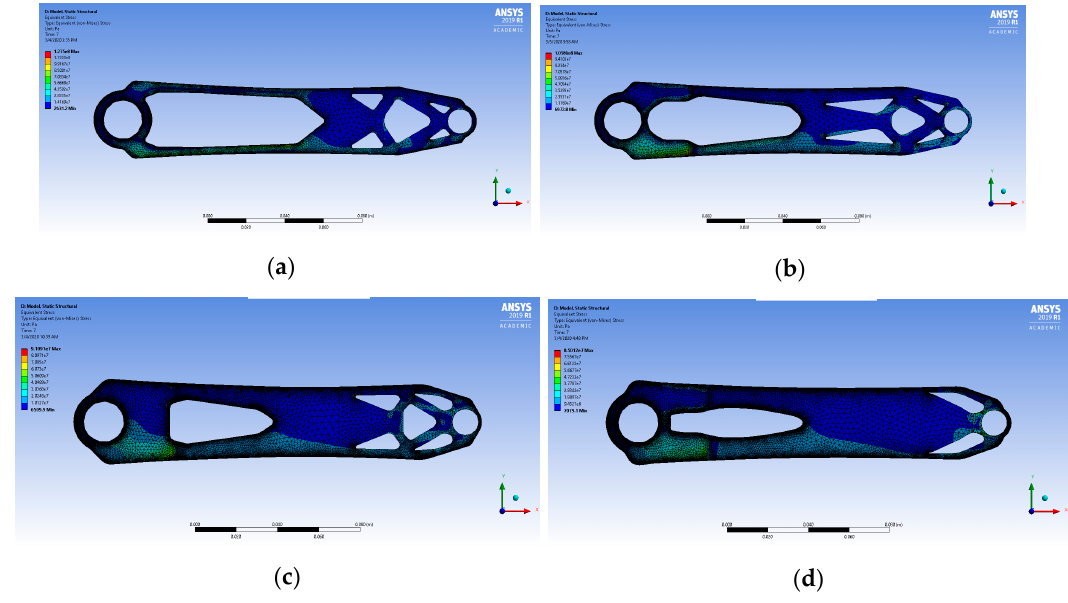
Figure 10. Effect of mass constraint in compliance minimization: ( a ) 30%, ( b ) 40%, ( c ) 50%, ( d ) 60%.